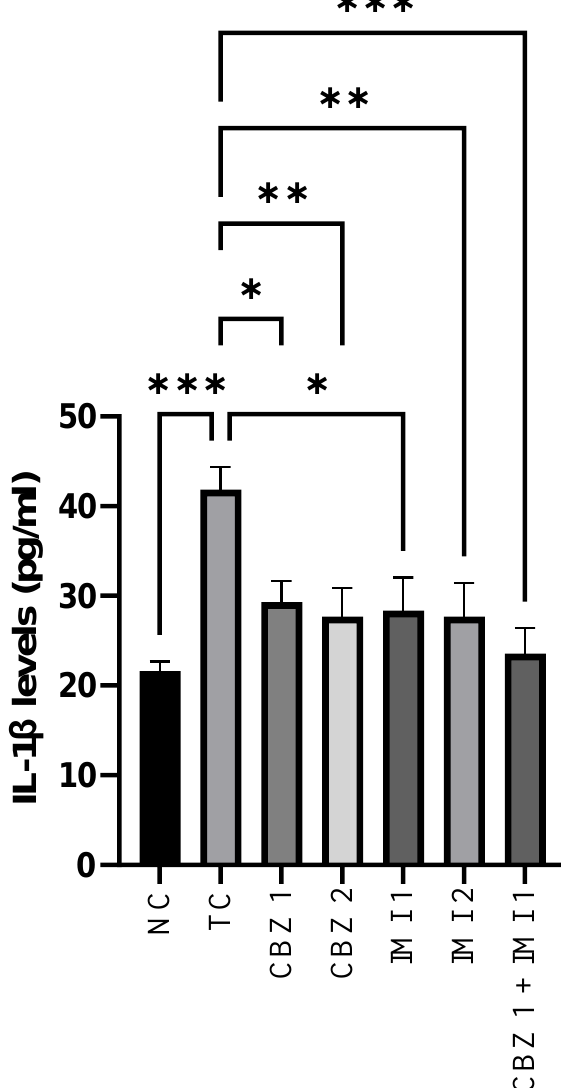
Figure 3. The effect of CBZ (20 and 50 mg/kg), IMI (10 and 20 mg/kg) and CBZ (20 mg/kg) + IMI (10 mg/kg) on hippocampal IL-1 β levels. Statistical significance between means from toxic control and other groups was correlated by applying one-way ANOVA followed by post hoc Dunnet’s test. ( p < 0.05 *, p < 0.01 **, p < 0.001 *** significance levels). CBZ, IMI, and TC indicate carbamazepine, imipramine, and toxic control, respectively.